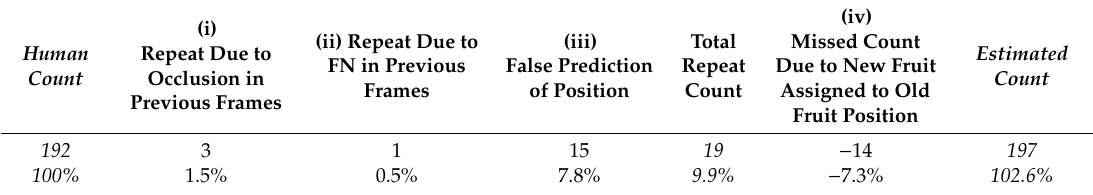
Table 1. Error attributions based on human assessment for fruit detection in 110 video frames using the tracking (MangoYOLO–Kalman filter–Hungarian algorithm)